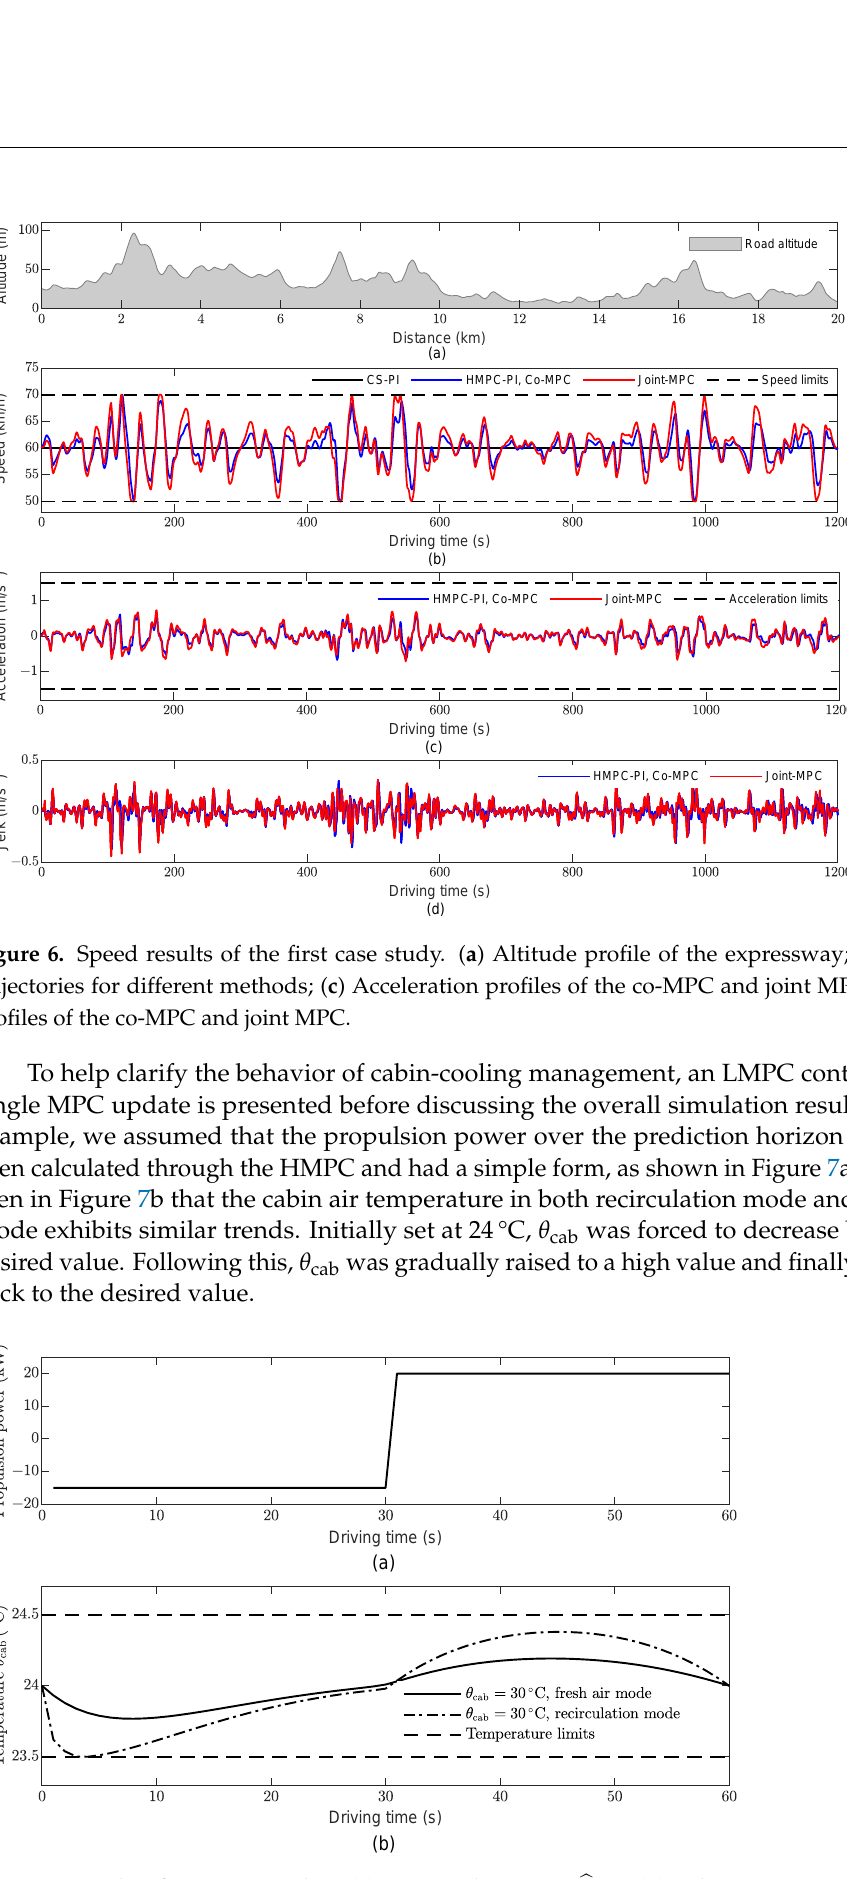
Figure 7. Results of an LMPC update. ( a ) Input to the LMPC: (cid:98) P prop ; ( b ) Cabin air temperature in two AC